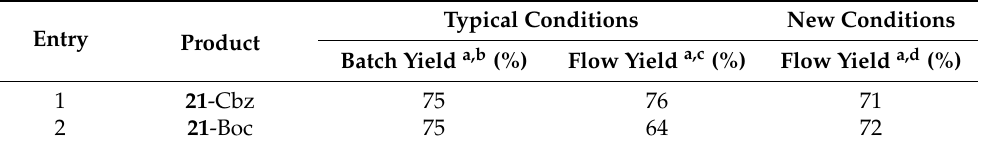
Table 3. Comparison of Pd(II)-catalysed carbonylation of 22 employing batch and flow